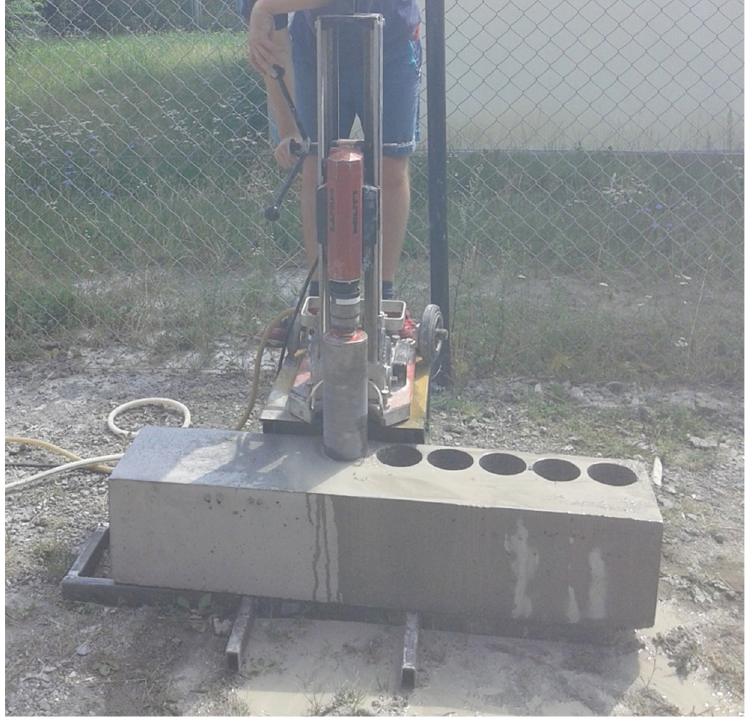
Figure 1. The taking of core samples using a drilling rig with a crown drill on a properly prepared stand.